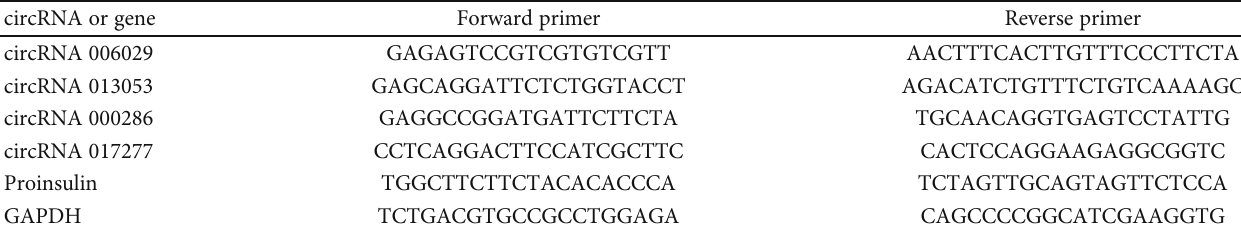
Table 1: qRT-PCR primers